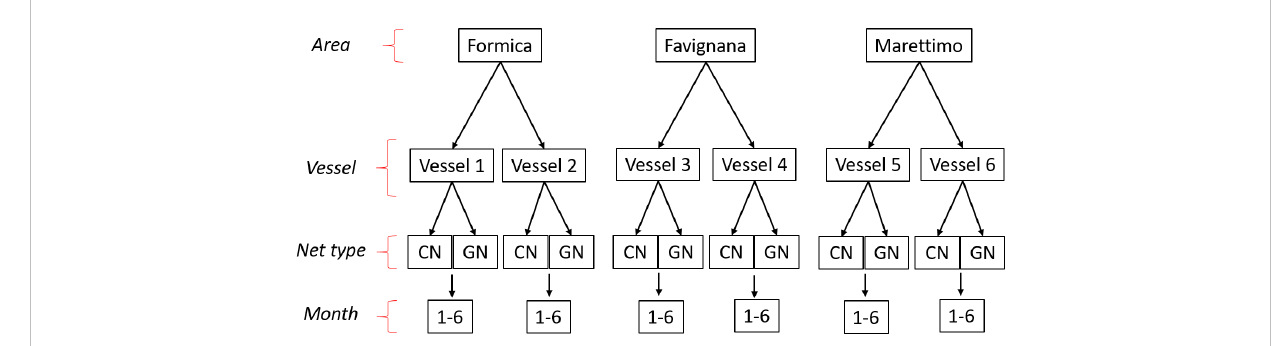
FIGURE 3 Schematic outlay of the experimental design applied in the presently reported